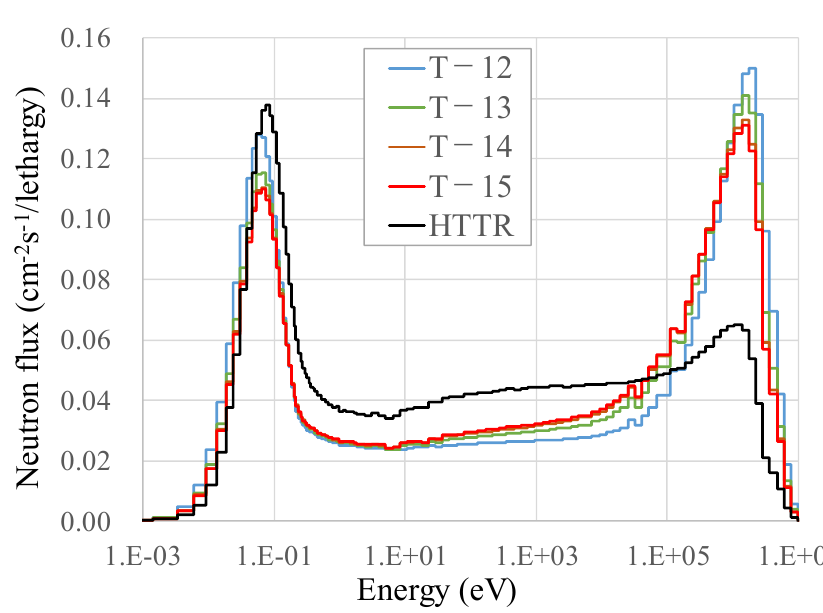
Figure 2. Configuration of core.